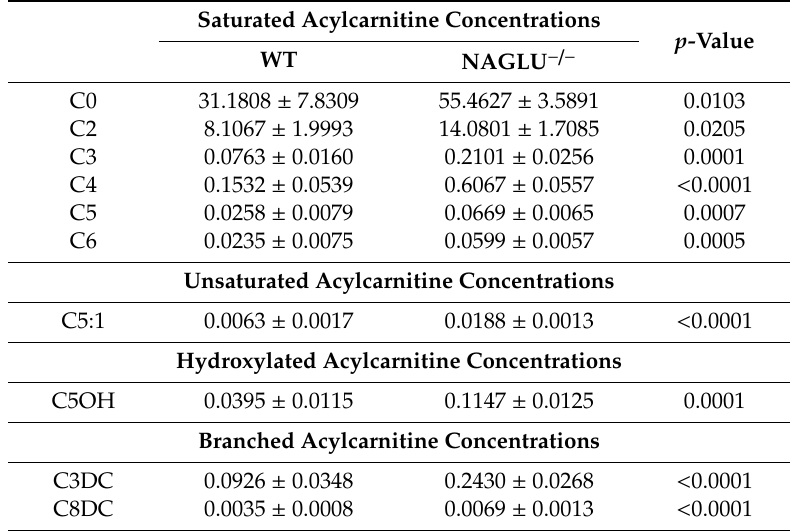
Table 3. Di ff erentially abundant metabolites in the